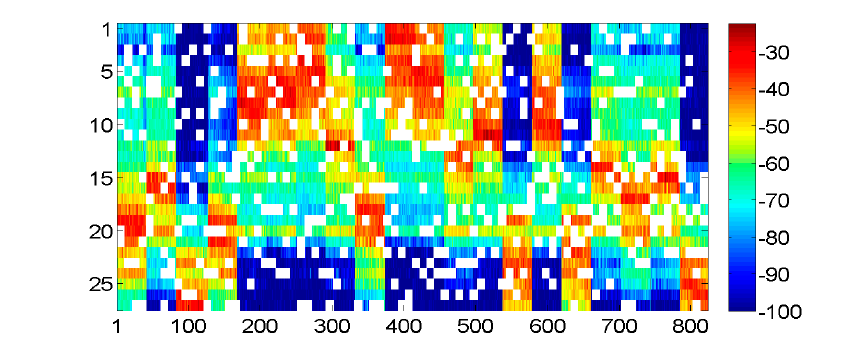
Figure 10. Radio map with five access points are powered off randomly.